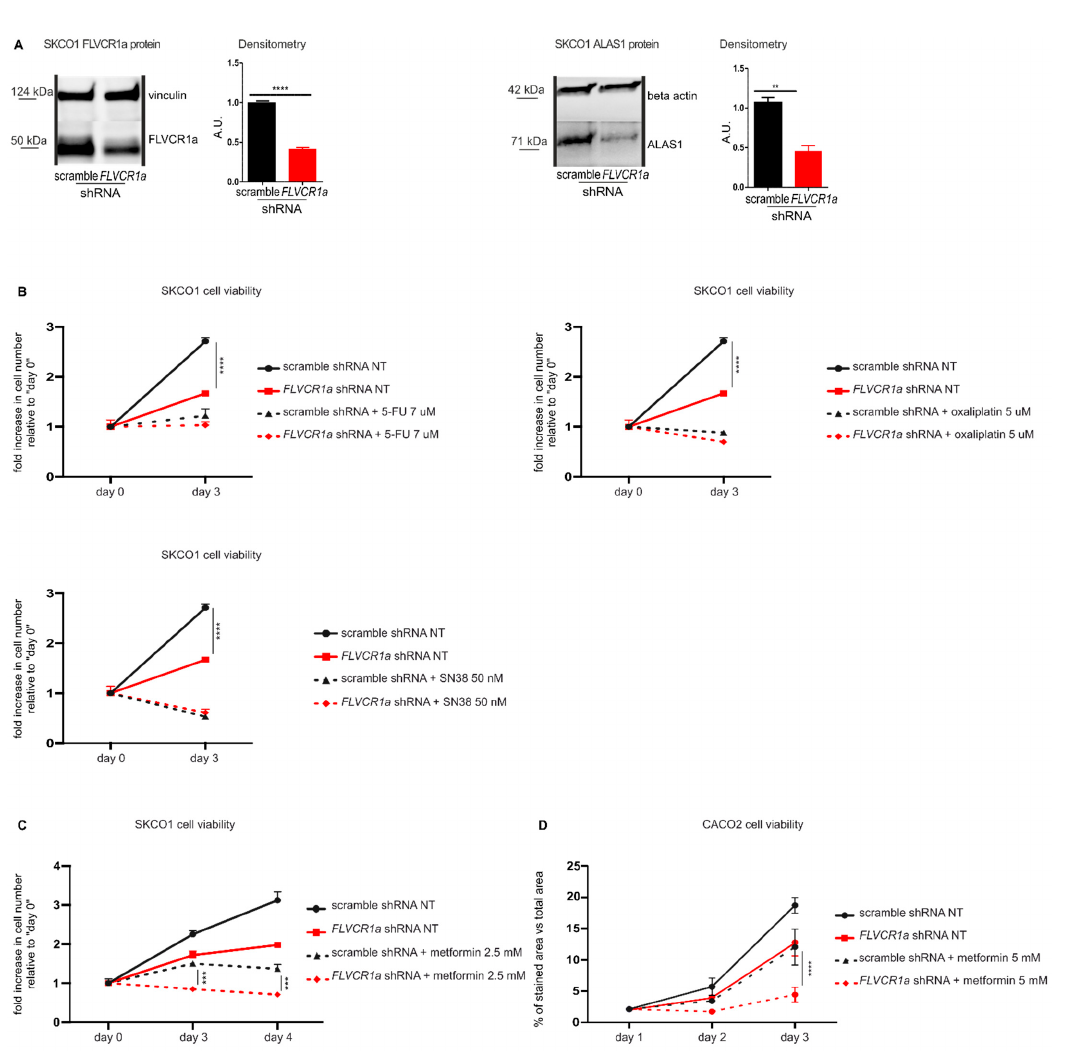
Figure 1. The down-modulation of the heme synthesis-export system, obtained by FLVCR1a silencing, sensitizes colorectal cancer cells to metformin. ( A )Western blot analysis of FLVCR1a and ALAS1 expression in SKCO1 cells. Vinculin and beta-actin expression are shown as a loading control, respectively. Cells in which the expression of FLVCR1a was down-regulated using a specific shRNA are compared to cells expressing a scramble shRNA. A representative blot is shown. For statistical analyses, a Student t -test was used. Densitometry shows mean ± SEM, n = 3 (FLVCR1a blot) and 2 (ALAS1 blot) biological replicates, ** p < 0.01, **** p < 0.0001. ( B , C ) Cell viability of SKCO1 cells untreated (NT) or treated with 7 uM 5-FU, 5 uM Oxaliplatin and 50 nM SN38 ( B ) or with 2.5 mM metformin ( C ), measured after two days (5-FU, Oxaliplatin and SN38) or two and three days (metformin) of drug exposure without medium refresh. Cells in which FLVCR1a expression was down-modulated using a specific shRNA are compared to cells expressing a scramble shRNA. Cell viability is measured as a fold increase over an untreated calibrator sample and expressed relative to day 0. For statistical analyses a two-way analysis of variance was performed, followed by the Bonferroni correction for multiple groups comparisons. Values represent mean ± SEM, n = 4 biological replicates, *** p < 0.001, **** p < 0.0001. ( D ) Cell viability of CACO2 cells was assessed by crystal violet staining on the indicated days. Cells in which the expression of FLVCR1a was down-regulated using a specific shRNA are compared to cells expressing a scramble shRNA; 5 mM metformin administration occurred at day 1 of cell proliferation and medium was maintained without refresh till the end of the experiment. Staining quantification is reported in the graph as the percentage of crystal violet stained area versus image total area. For statistical analyses, a two-way analysis of variance was performed, followed by the Bonferroni correction for multiple groups comparisons. Values represent mean SEM, n = 3 biological replicates, **** = p < ±